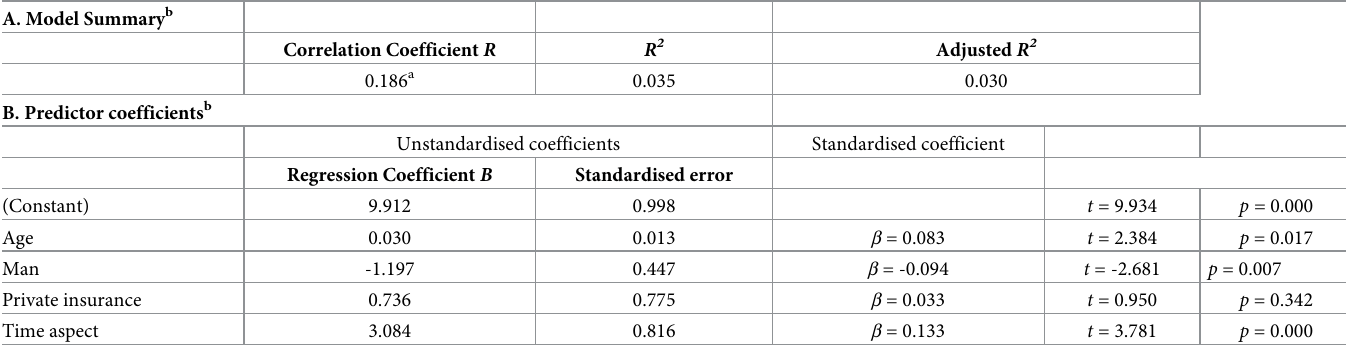
Table 6. Regression